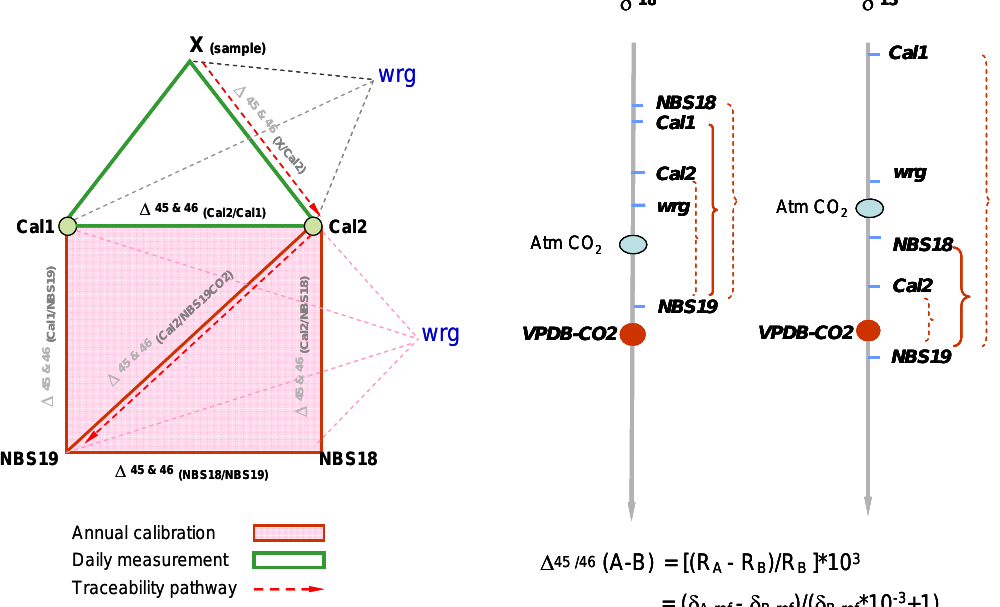
Figure 2 . On the left panel: a schematic of traceability in high-precision isotopic measurements using multiple carbonates, at the Stable Isotope Research Laboratory (SIRL), CRD/ASTD, Environment Canada. Where the pink square links the standards measured in annual calibrations and the green triangle links the standards and the sample X in daily measurements. The dotted lines (pink or gray) representing the pathways by that raw δ 45 / 46 values are measured, and the solid lines (dark red or green) link the standards or sample from which Big Delta values can be derived; the red dotted lines with arrows indicate the traceability pathway, i.e., having the sample anchored on VPDB-CO 2 scale though two Big Delta values ( 1 X/ Cal2 and 1 Cal2/NBS19CO ). In the right-hand panel, a schematic of relative positions on the primary VPDB-CO 2 scale (in δ 13 C VPDBCO and δ 18 O VPDBCO ) for the standards, the WRG and atmospheric CO 2 . The arrow heads of gray lines are towards more positive values on VPDB-CO 2 scale. The Big Delta values relating NBS18 and NBS19 have been used as the quality control criteria for obtaining other Big Delta values (e.g., 1 Cal1/NBS19CO , 1 Cal2/NBS19CO and 1 Cal2/Cal1 ) during annual calibrations. When the δ 13 C NBS18CO and δ 18 O NBS18CO match with the recommended values by IAEA, the other Big Delta values are considered valid. 1 Cal2/Cal1 is measured on both annual calibrations and daily measurements (see the left panel), and has been used as the quality control criteria for daily measurements. Comparing the 1 Cal2/Cal1 values with these obtained from annual calibrations, the quality of the primary anchor (Cal2) value is ensured and validated. Therefore, the traceability and quality of samples in daily measurements have been guaranteed.